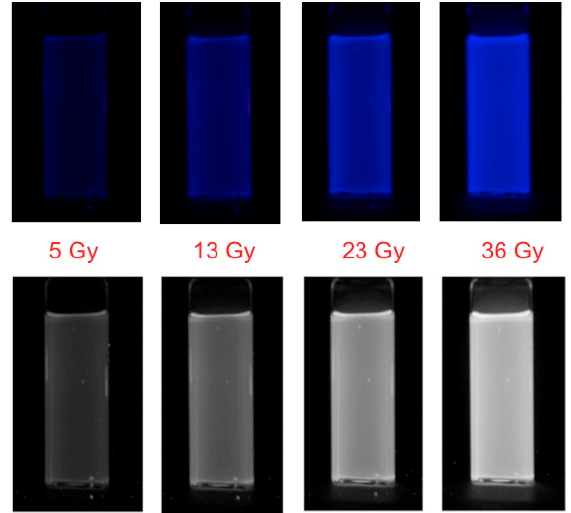
Figure 2. Upper : The full RGB color fluorescence in UV light of a 10 × 10 mm 2 cuvette containing a 1.4 mM solution of maleimido-pyrene in tertiary-butyl acrylate, as a function of accumulated dose in a GC200 γ -ray source (dose rate ~2 Gy/min). Lower : The same cuvette with the fluorescence shown as blue-pixel gray-scale values.